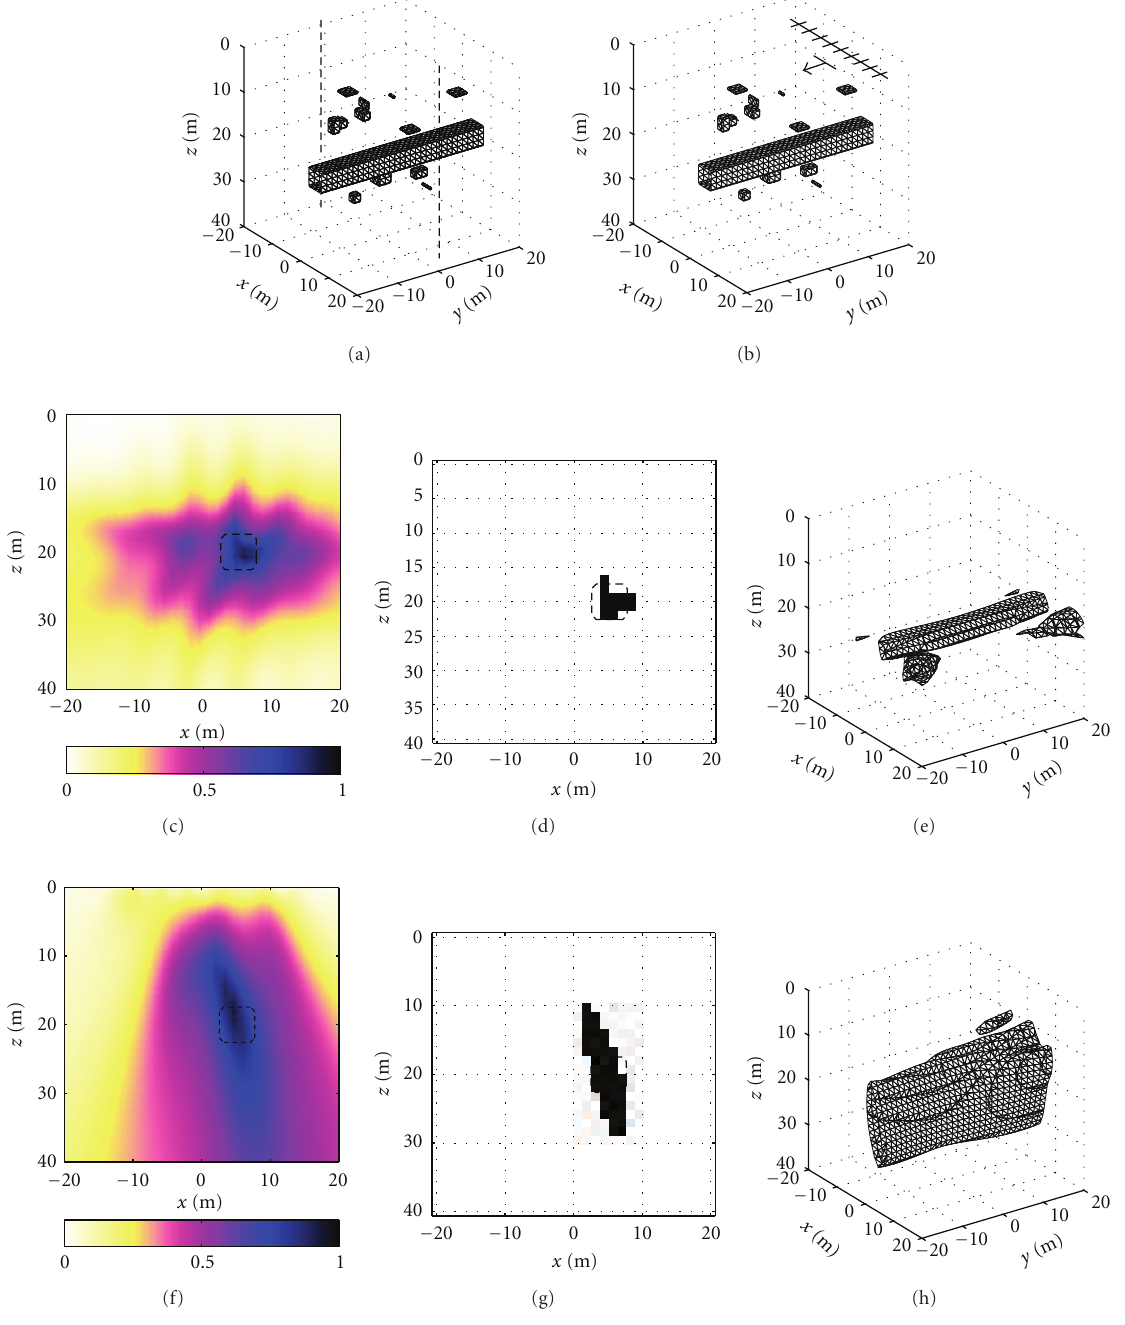
Figure 5: LSM imaging of the tunnel in cluttered scenario. (a) Cross-hole measurement configuration; (b) surface moving array measure- ment configuration. Results achieved with borehole measurement configuration: (c) normalized logarithmic plot of the LSM indicator; (d) binarized LSM indicator with threshold 0.75; (e) binarized LSM 3D indicator in the whole region. Results achieved with surface measurement configuration: (f) normalized logarithmic plot of the LSM indicator; (g) binarized LSM indicator with threshold 0.75; (h) binarized LSM 3D indicator in the whole